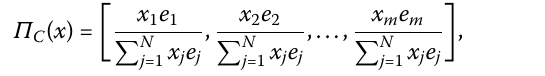
Figure 3 Example 4.2, top left: N = 50; top right: N = 100; bottom left: N = 200; bottom right: N =